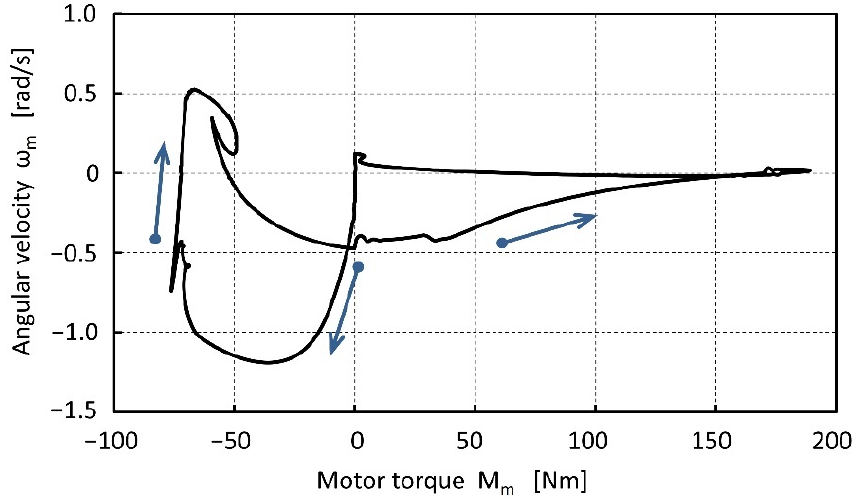
Figure 11. Mechanical trajectory at the hip joint drive during a walk with a cycle period T c = 3 s and a step length l = 0.46 m.